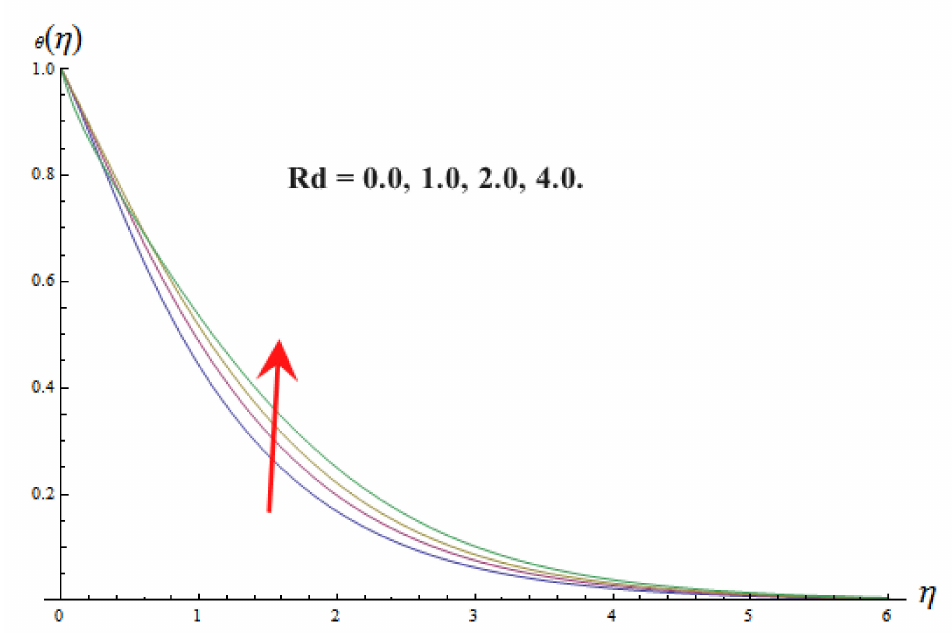
Figure 10. Impact of Rd on θ ( η ) keeping Γ = 0.5, Pr = 2, Br = 2, λ = 2, Ec = 0.2, Ha = 0.2, β 1 = 0.2, λ 1 = 0.2, K ∗ =